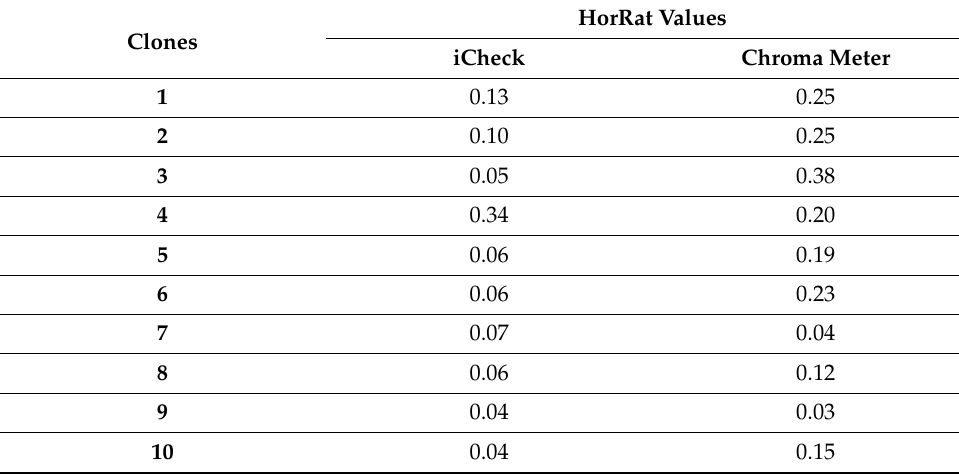
Table 2. HorRat values for iCheck and Chroma